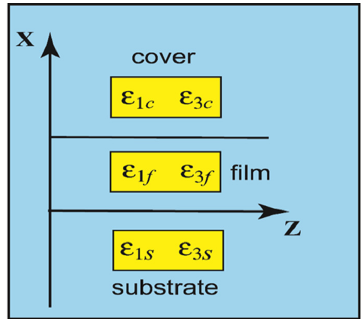
Figure 3. Planar, step-index, waveguide with guided waves prop- agating along z , for which the central film ( f ) is a hyperbolic metamaterial. The cover ( c ) and substrate ( s ) can be purely isotropic, or anisotropic, with positive tensor